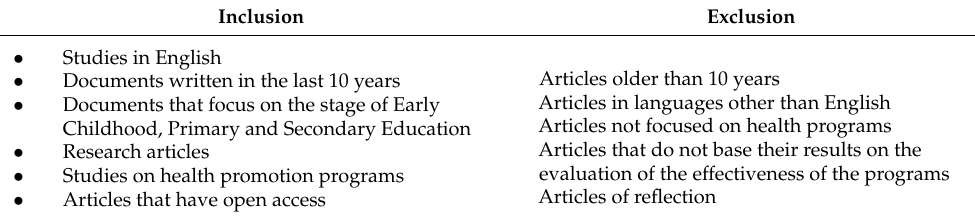
Table 1. Estimated inclusion and exclusion